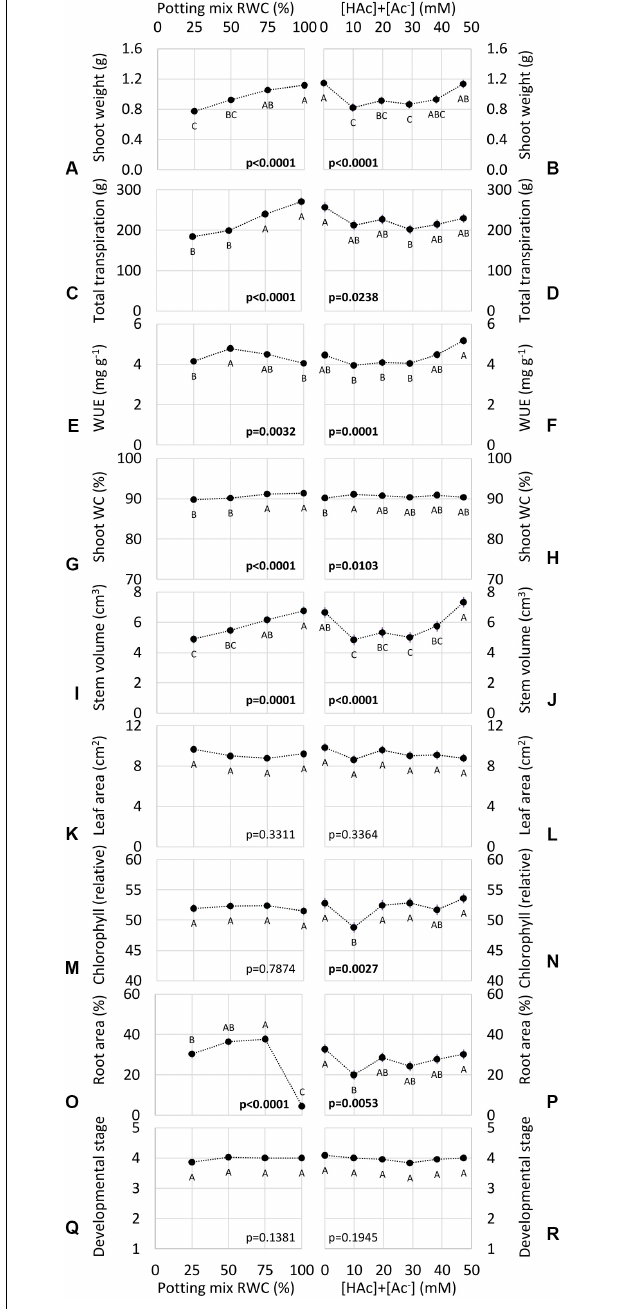
FIGURE 6 | Potting mix Relative Water Content (RWC) and total (undissociated and dissociated) acetic acid ([HAc] + [Ac − ]) treatment impacts in the outdoor Water Use Efficiency (WUE) assay on a range of seedling growth phenotypes (means ± 1 standard error of the mean), including shoot weight (A,B) and Water Content (WC) (G,H) , leaf area (K,L) and chlorophyll content (M,N) , stem volume (I,J) , root area (O,P) and plant transpiration (C,D) , WUE (E,F) and developmental stage (Q,R) . None of the water by acetic acid interactions were significant ( p > 0.1), so only the main effects are presented. Contrasting letters denote significant differences ( p < 0.05) within water (A,C,E,G,I,K,M,O,Q) or acetic acid (B,D,F,H,J,L,N,P,R) treatments (blocked factorial ANOVA; Tukey pairwise comparison; n =